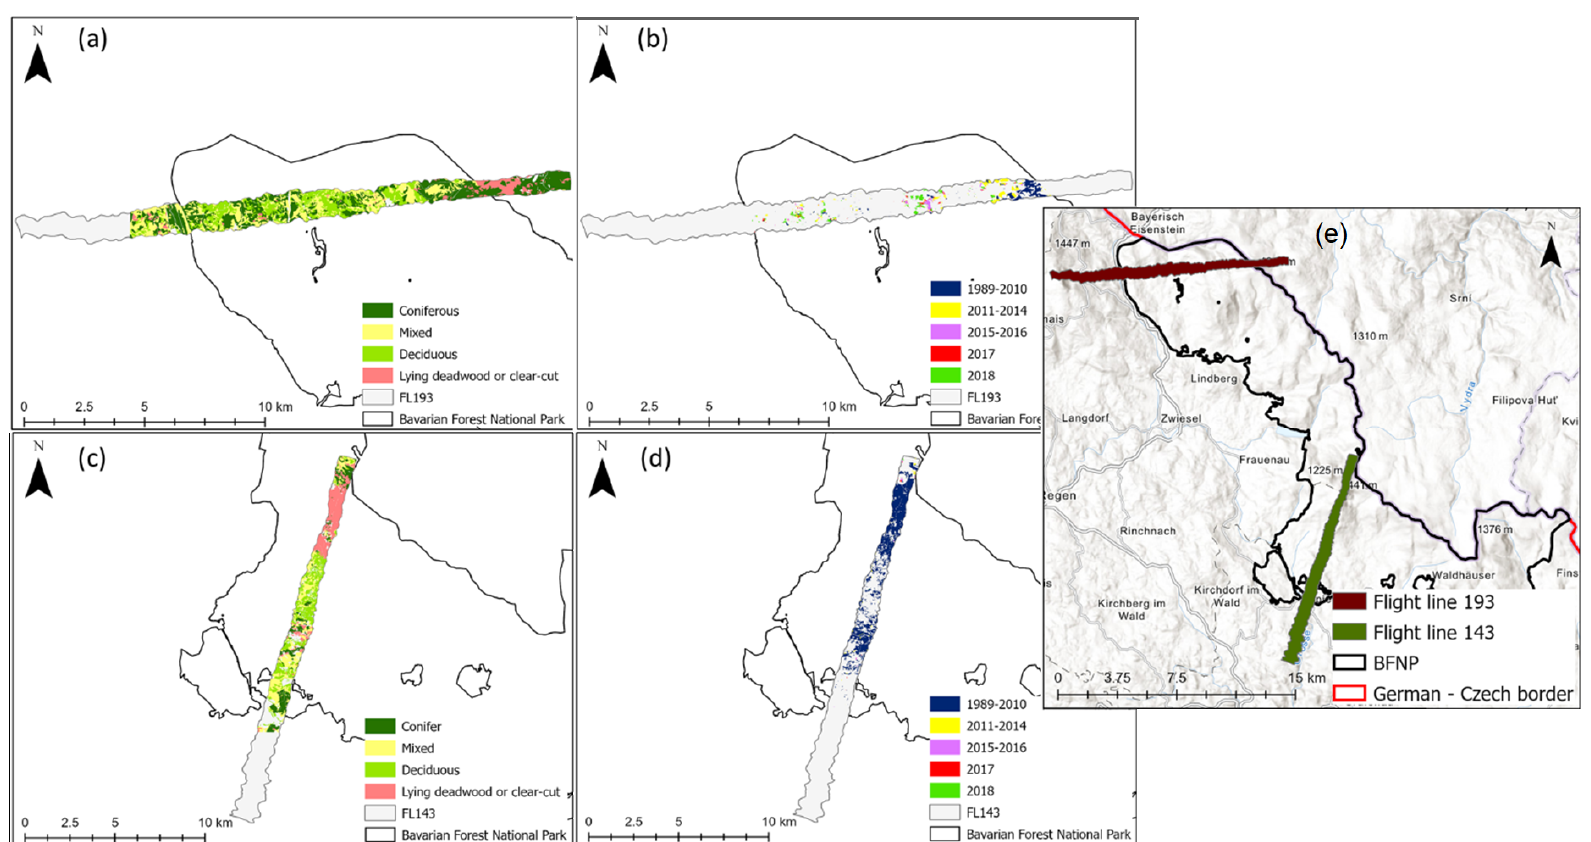
Figure A1. ( a ) Flight line 193: Forest classification map, ( b ) Flight line 193: Deadwood classification map, ( c ) Flight line 143: Forest classification map ( d ) Flight line 143: Deadwood classification map, ( e ) Location plan of flight line 193 and 143 in relation to the Bavarian Forest National Park. Forest classification map from land cover map available from the national park administration. Deadwood classification map from infestation map (obtained from aerial photographs) available from the national park administration.